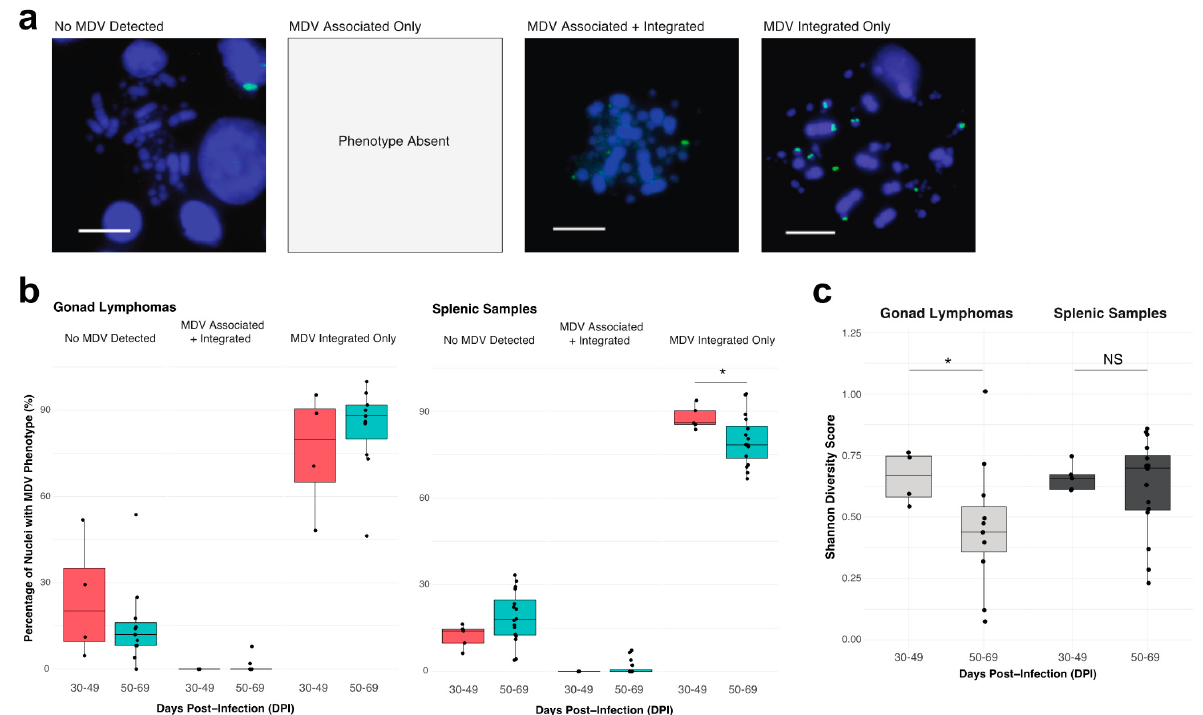
Figure 2. MD gonad lymphomas and splenic samples primarily consist of cells with an MDV telomere-integrated only phenotype and gonadal cell populations exhibit lower diversity in terms of MDV integration profiles at later collection timepoints: ( a ) Representative MDV cellular phenotypes of MD tumors for the oncogenic JM/102W MDV strain, analyzed within study part I. The “No MDV Detected” or null phenotype lacks any evidence for MDV FISH signals associated with or integrated into the host bird chromosomes (DAPI/blue). The “MDV chromosome-associated” phenotype was absent from MDV-transformed tissue samples. The “MDV chromosome-associated/telomere-integrated” phenotype consists of both diffuse chromosome-associated MDV signals surrounding the chromosomes and bright, punctate integrated-MDV signals at the host telomeres. The telomere-integrated only MDV phenotype is exclusively comprised of distinct, punctate FISH MDV signals at the telomeres. Scale bar = 0.5 µ M; ( b ) Percentage of cells with detected MDV cellular phenotypes for tissue collection time ranges, 30–49 dpi (orange) versus 50–69 dpi (teal blue), of MD gonad lymphomas (left plot; n = 15) and splenic samples (right plot; n = 21) in study part I. Line inside box depicts median value, box depicts interquartile range (IQR), and whiskers depict IQR+/ − 1.5*IQR. Dots indicate tumor values. * p < 0.05; ( c ) Shannon diversity score of MD gonad lymphomas (left plot, light gray; n = 15) and splenic samples (right plot, dark gray; n = 21) from tissue collection time ranges, 30–49 dpi versus 50–69 dpi in study part I. A higher score indicates a greater diversity, in terms of MDV integration profiles, of the FISH-analyzed cell population in a tissue sample. Line inside the box depicts median value, box depicts interquartile range (IQR), and whiskers depict IQR+/ − 1.5*IQR. * p <